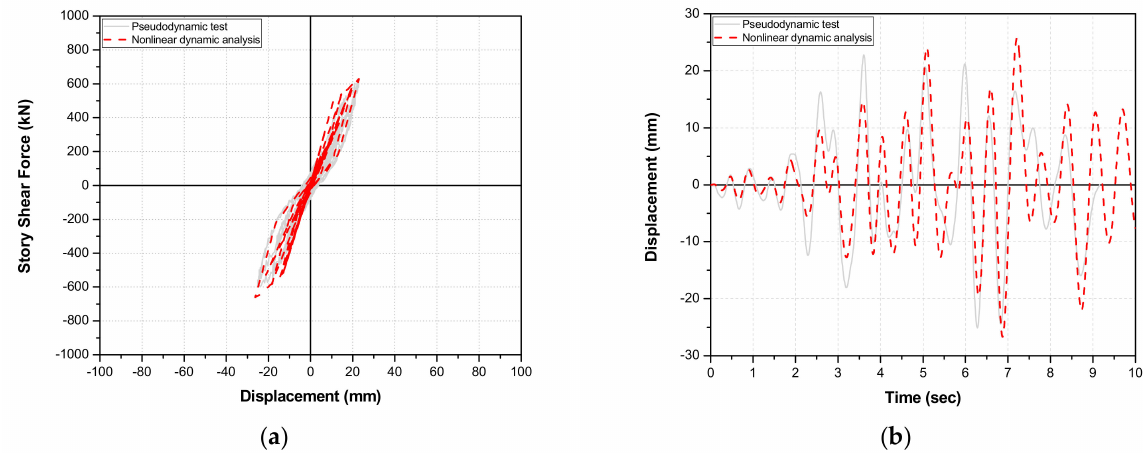
Figure 23. Comparison of non-linear dynamic analysis and pseudo-dynamic test results of test frame retrofitted with